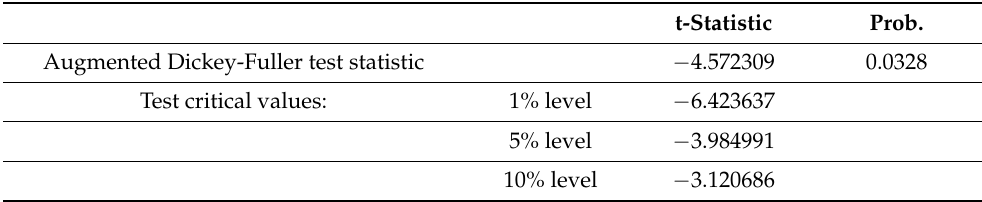
Table 13. Augmented Dickey–Fuller Unit Root Test on the number of FinTech companies.